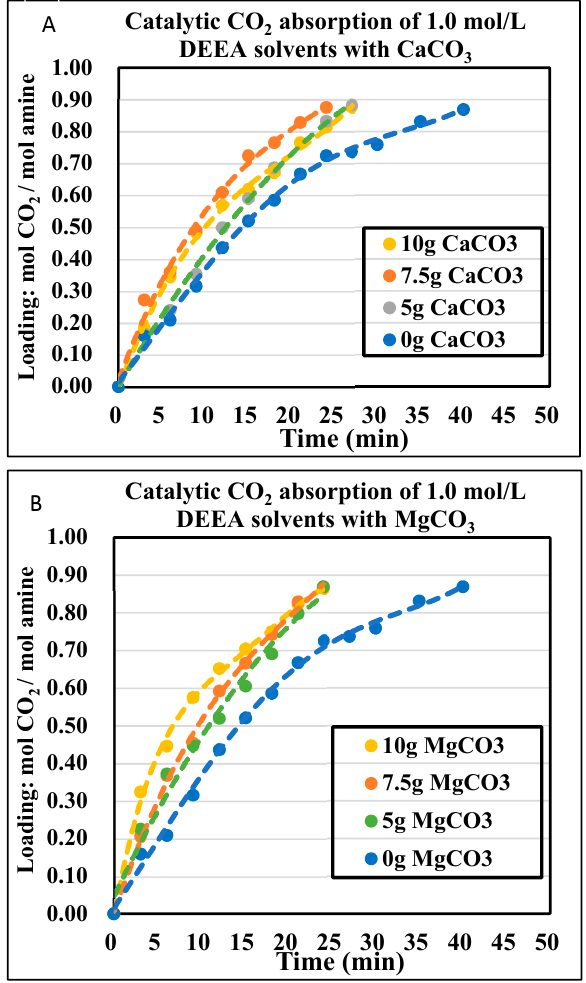
Figure 3. Catalytic CO 2 absorption curves of 1.0 mol/L DEEA solvents at 293 K and 1 atm. ( A ) CaCO 3 0–10 g; ( B ) MgCO 3 0–10 g. Molecules 2019 , 24 , x FOR PEER REVIEW